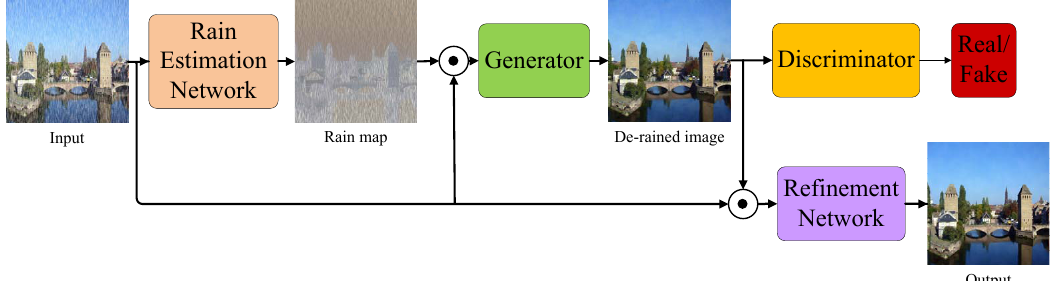
Figure 2. Overview of the proposed IGAN-SID method. REN aims to estimate the rain map. The generator, whose input is the concatenation of the rain map and the original rainy image, is designed for rain streak removal. The RFN, whose input is the concatenation of the de-raining result and the original rainy image, aims to restore the lost details in the de-raining